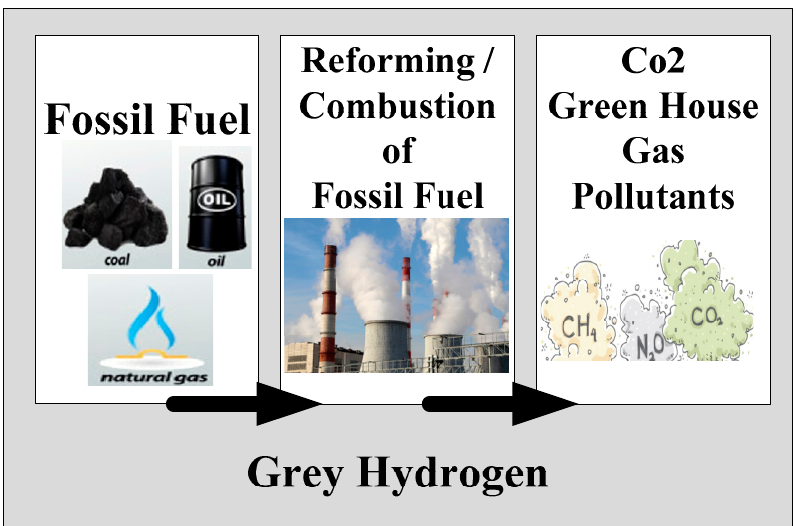
Figure 5. Schematic of Grey hydrogen production.